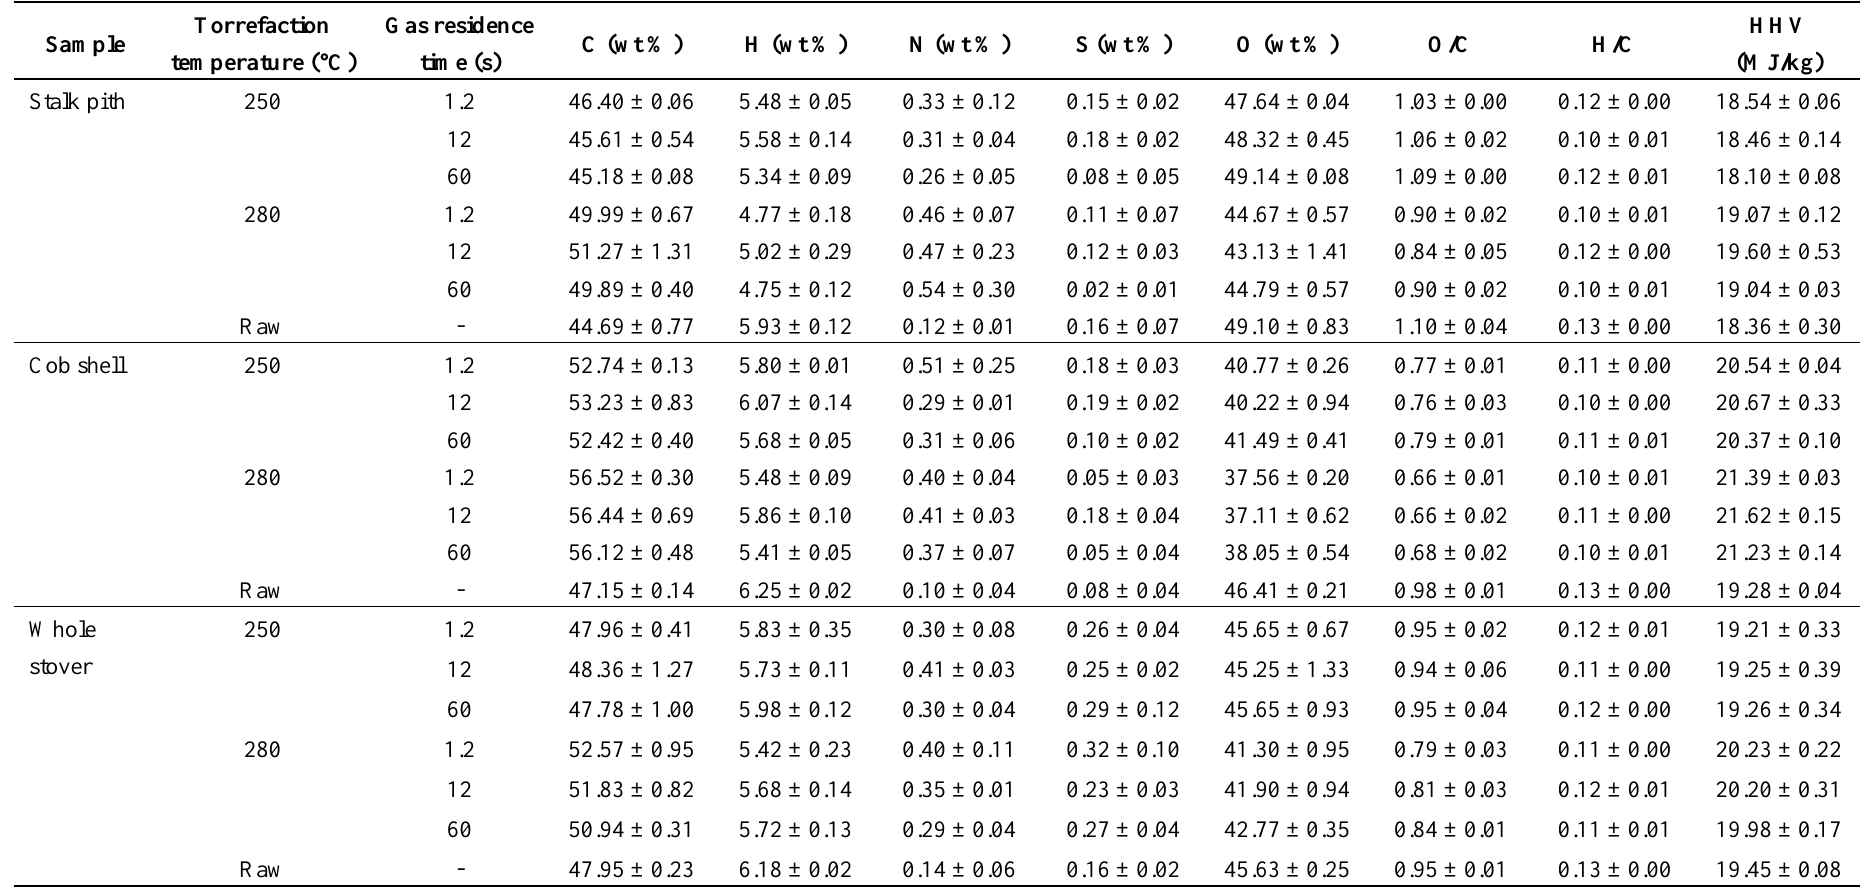
All values are expressed on dry basis as a mean of two measurements ± standard